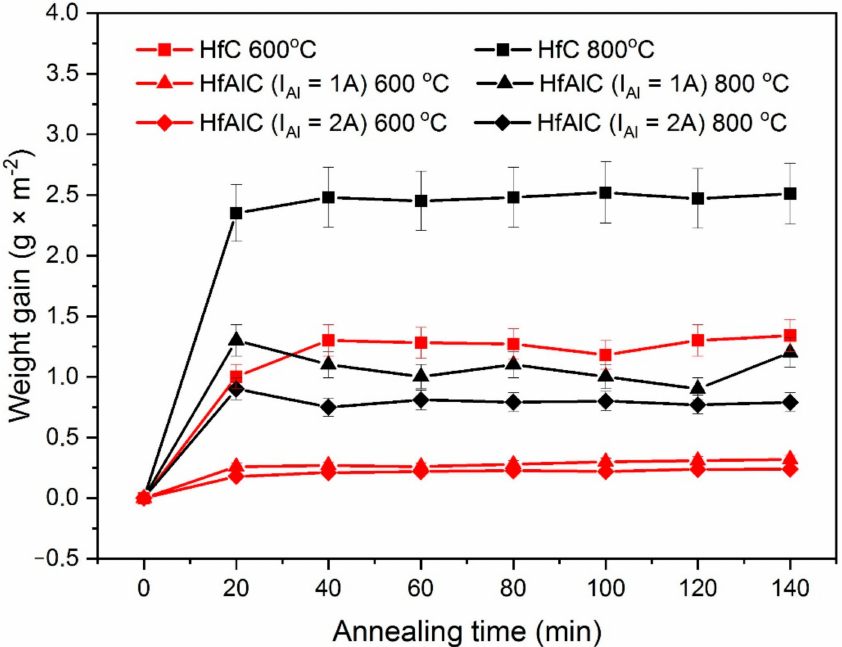
Figure 3. Weight gain of alumina sample coated by 10 µ m Hf–Al–C and 10 µ m HfC in dependence on the annealing time and annealing